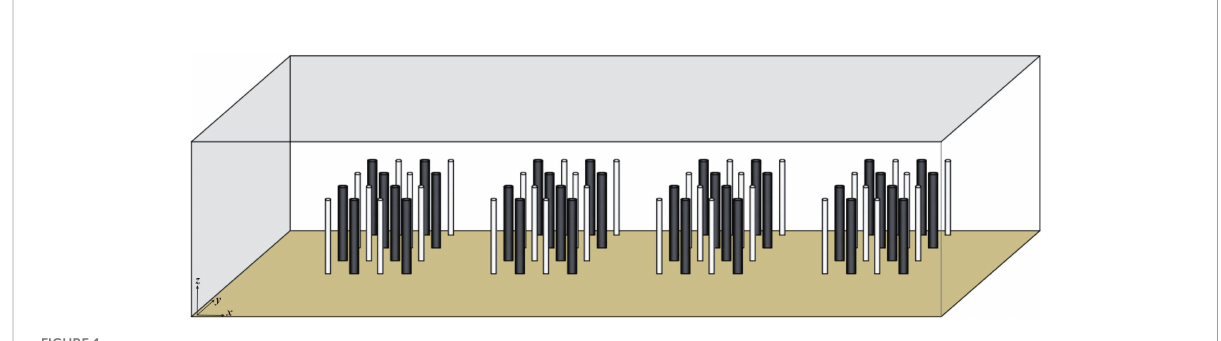
FIGURE 1 Three-dimensional view of numerical calculation